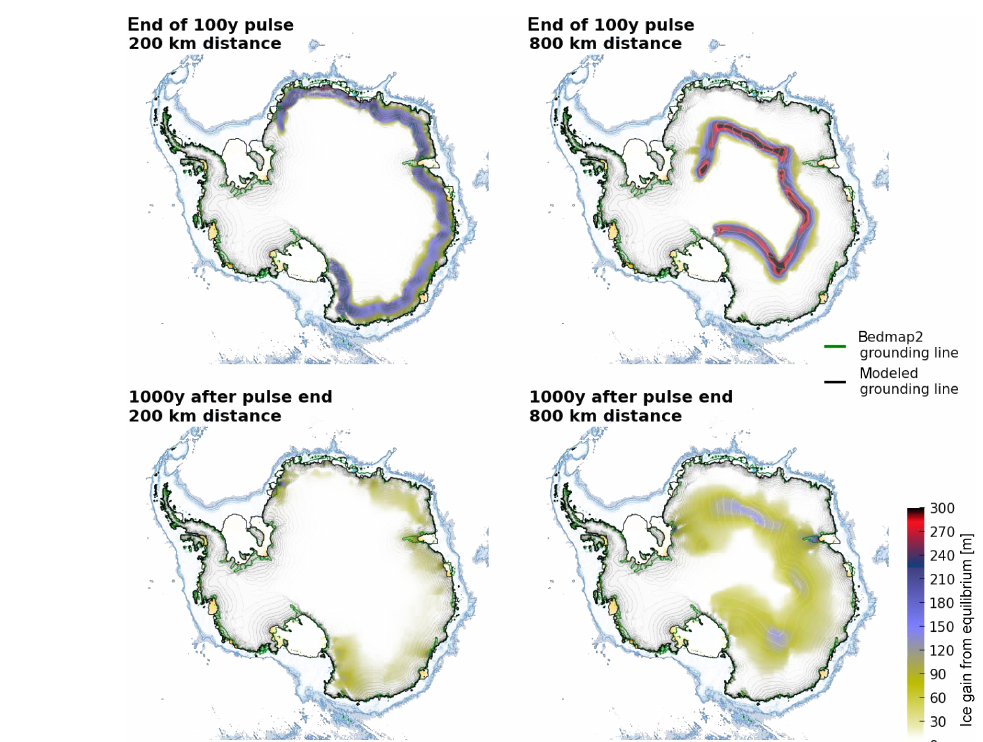
Figure 3. Difference in ice thickness compared to the initial state. Ice thickness gain at the end of the 100-year-long mass addition (upper panels) and 1000 years after the forcing ended (lower panels). The close-to-coast simulation (left panels) has lost most of the added ice to the ocean after 1000 years while there is a broad ice gain in the 800km simulation (right panels). Figures are shown for the strongest scenario of 10mmyr − 1 of sea-level mitigation and without accounting for latent-heat